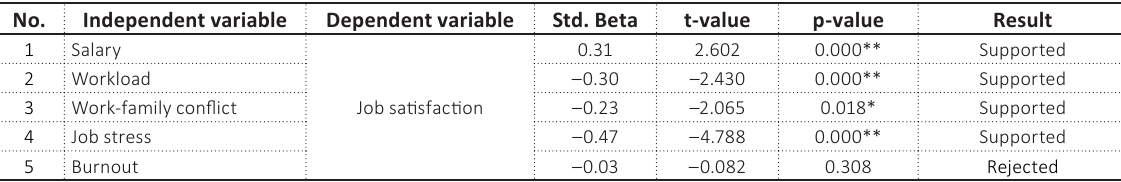
Table 2. Summary of multiple regression ratios and hypotheses